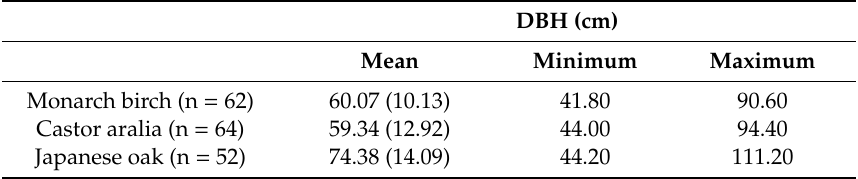
Figure 2. High-value timber species. ( a ) Monarch birch ( Betula maximowicziana ), ( b ) Castor aralia ( Kalopanax septemlobus ), and ( c ) Japanese oak ( Quercus crispula ). Table 1. Summary statistics of field measured trees (standard deviation in parenthesis).